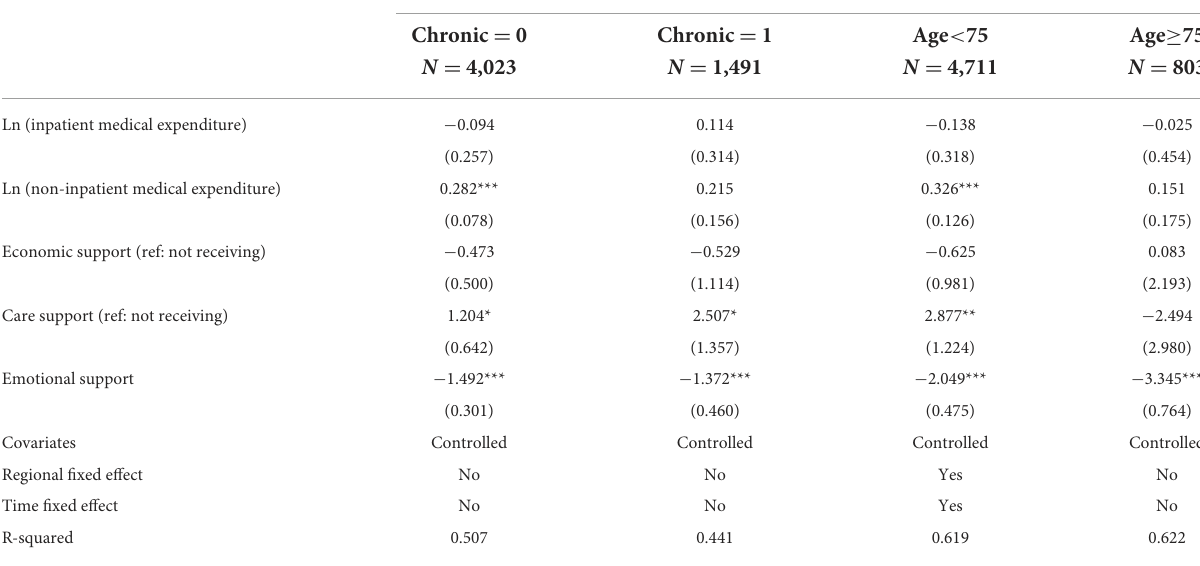
TABLE 5 Sub-samples regression results regarding the effects of intergenerational support and medical expenditures on depression among the rural older adults.